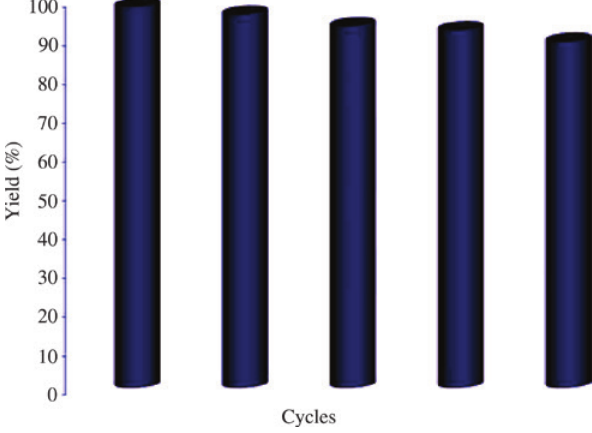
-clay catalyst. x